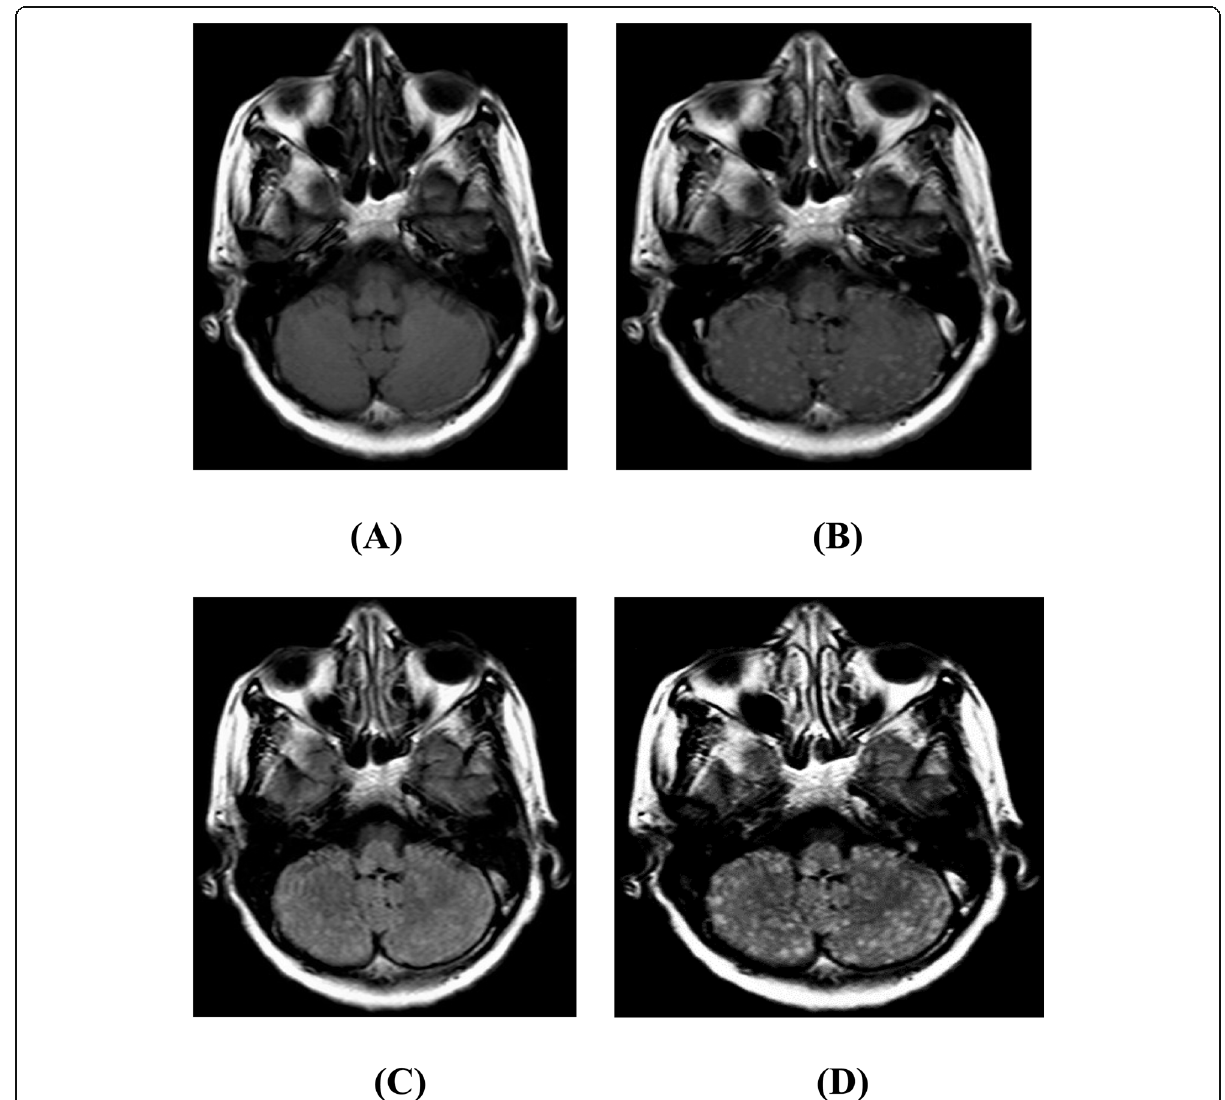
Fig. 4 Male patient aged 57 years known as bronchogenic carcinoma with brain metastases. A , B Axial pre and post contrast T1WI showed multiple tiny enhancing lesions scattered at both cerebellar hemispheres and medulla. On axial pre-contrast FLAIR ( C ), the lesions were few and displayed faint high signal intensity. D Axial post-contrast FLAIR images showed an increased number of enhancing lesions that appeared more hyperintense and demonstrated better lesion to background contrast than in post-contrast T1W1 ( B